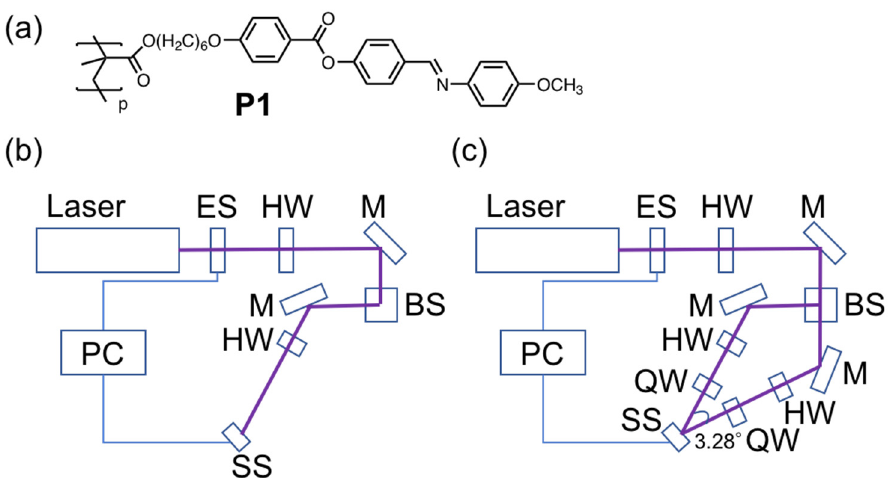
Figure 1. ( a ) Chemical structure of NBA liquid crystalline polymer P1. Experimental setup for axis-selective photoreaction ( b ) and holographic exposure ( c ). ES, shutter; HW, half-wave plate; M, mirror; BS, beam splitter; QW, quarter wave plate; SS, sample stage; PC, personal computer.